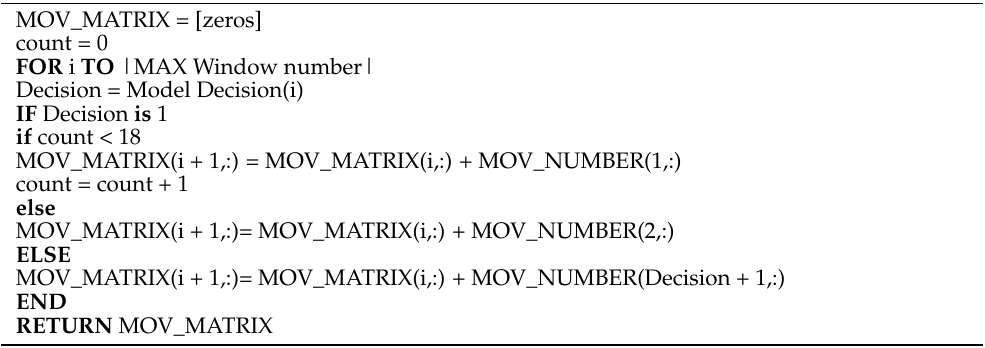
Algorithm 3 Pseudocode for the Creation of a Motion File From Classification. MOV_NUMBER Matrix Corresponds to Advancement Vector Table 4 MOV_MATRIX = [zeros] count =